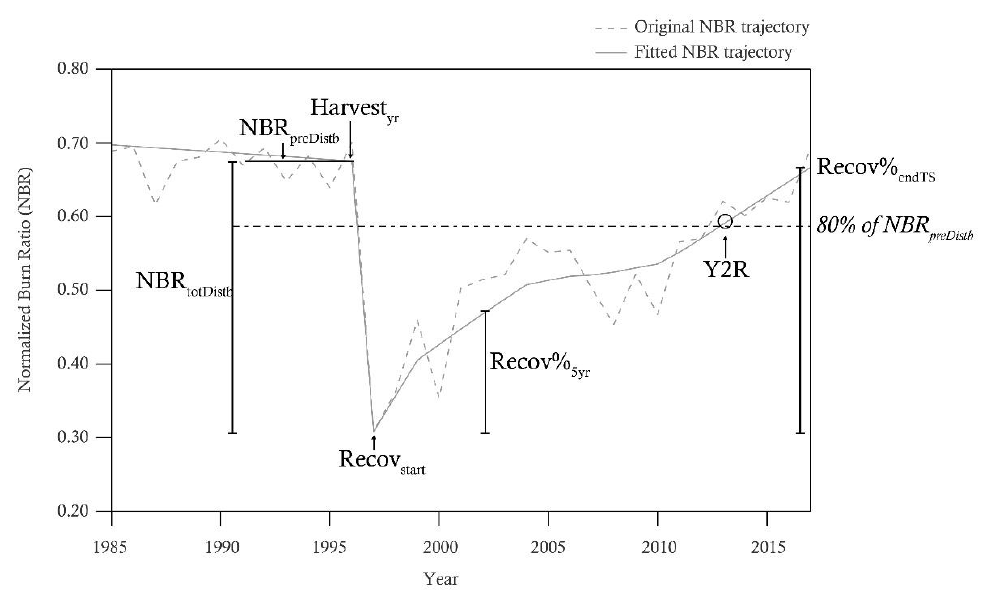
Figure 3. Graphic illustrating the methods for calculating various spectral recovery metrics from a sample normalized burn ratio time series.